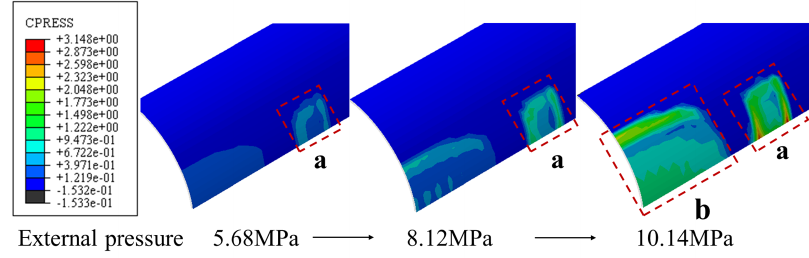
Figure 16. Interaction stress diagram at the limit state.